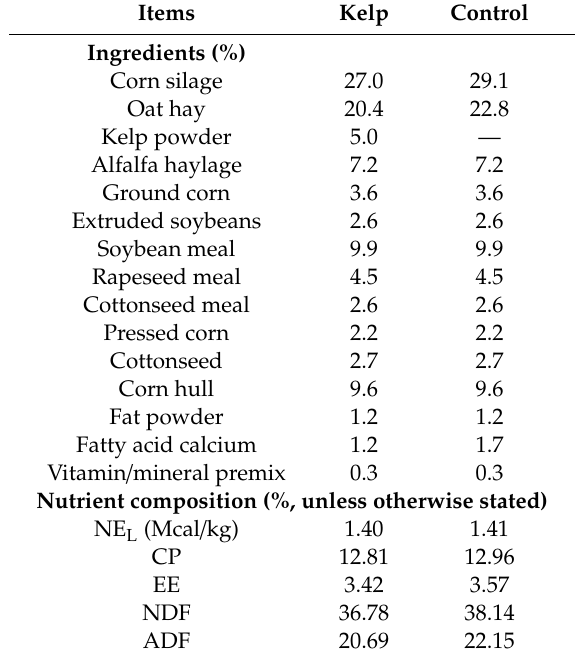
Table 1. Ingredients and chemical composition of the diets (DM basis) A,B